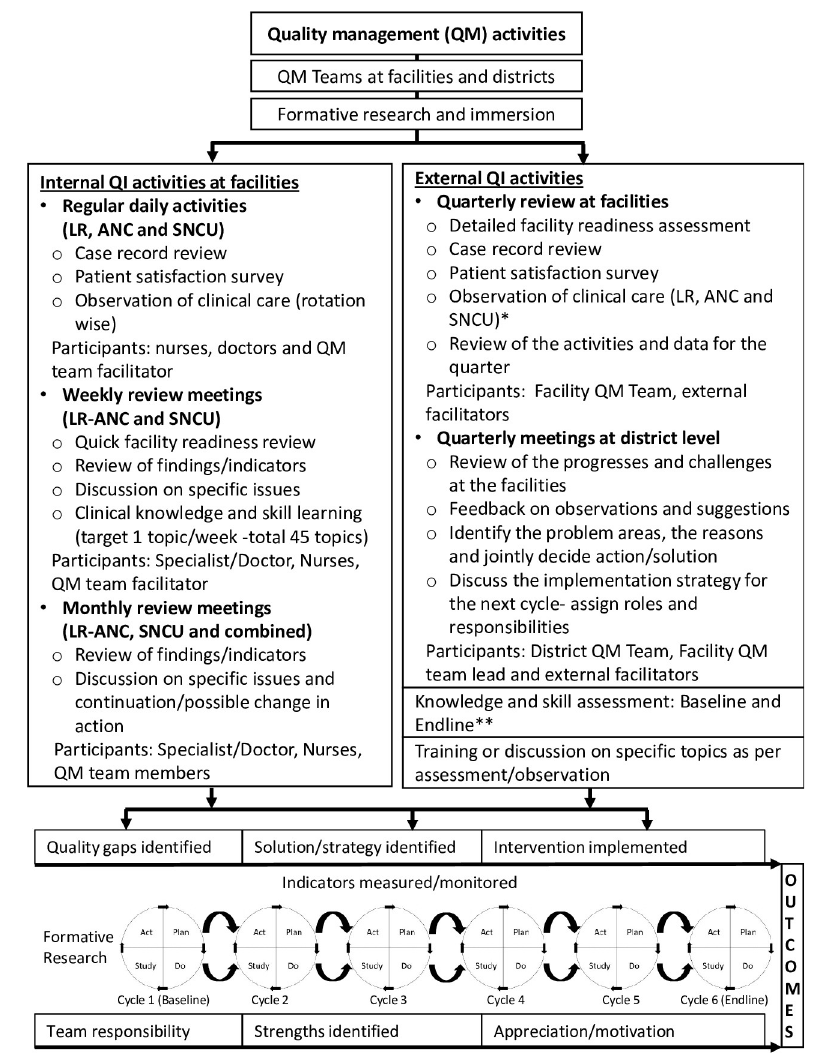
Fig 1. The quality management activities implemented during the project. Note: QI- Quality improvement and QM- Quality management. � Observations in labour room (LR)/antenatal clinic (ANC)/sick newborn care unit (SNCU) focused on the care for women in labour, antenatal care, essential and sick newborn care and hand hygiene at all places. �� The knowledge and skill assessments included respective care for women in labour and essential and sick newborn care in the labour room and SNCUs